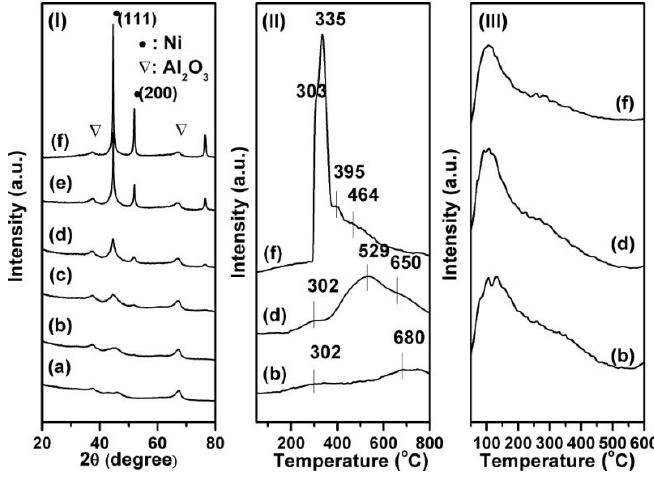
Figure 5. The XRD ( I ); H 2 -TPR( II ); and NH 3 -TPD ( III ) of Ni/Al 2 O 3 -450 with different loadings of Ni. ( I ) Al 2 O 3 ( a ), and 5% ( b ), 9.5% ( c ), 17.5% ( d ), 29.6% ( e ) and 40% ( f ). Table 2. Influence of Ni loading on the hydrolysis of glycerol over Ni/Al 2 O 3 -450 catalysts. Selectivity (%) Ni loading (%) Time (h) Conversion (%) 1,2-PDO EG Others 5 12